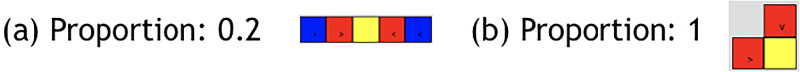
Morphology (a) is disproportional and (b) is proportional.